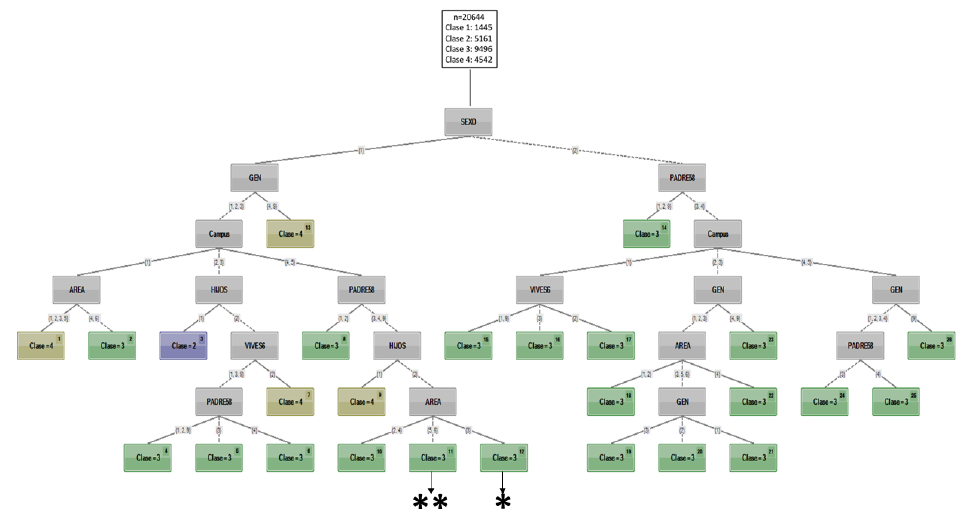
Figure 3. Example of identification of risk factors in drug use in students using the TAID-LCA algorithm. The output of the TAID-LCA is a ternary tree show in Figure 3, yielded from the recursive partition by the values of the explanatory variables, where the latent variable is the target one (it summarizes the manifest